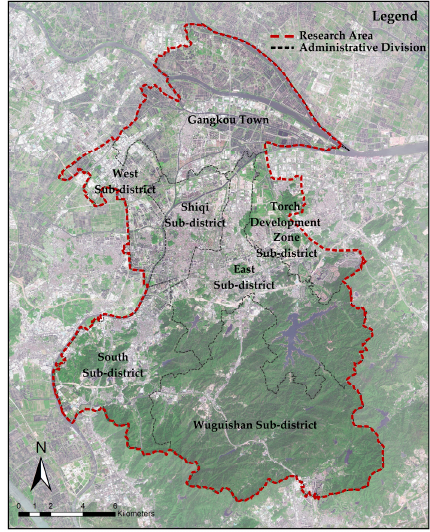
Figure 3. Study area and its administrative divisions.